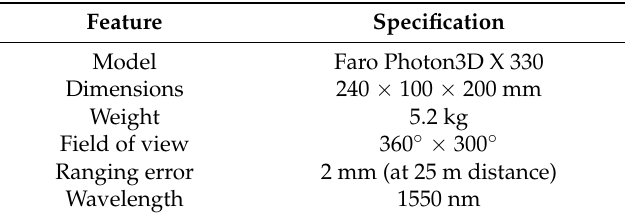
Table 2. Technical features of the terrestrial laser scanning